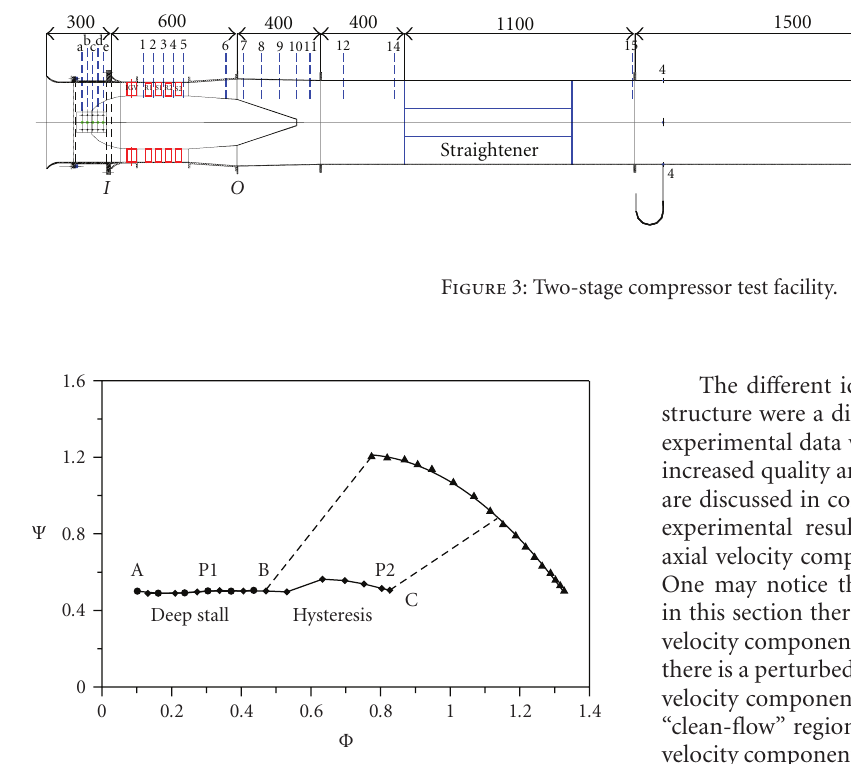
Figure 4: Compressor characteristic curve.